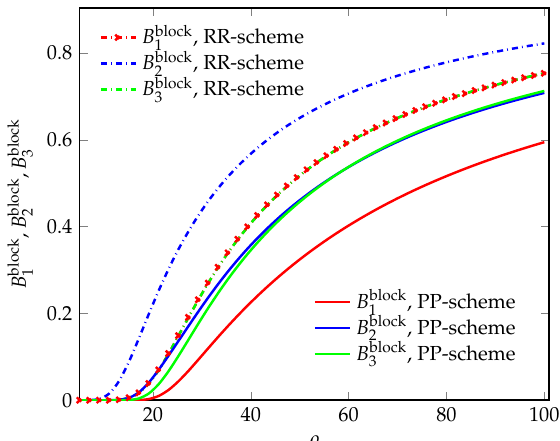
Figure 8. The blocking probabilities for arriving requests vs. the offered